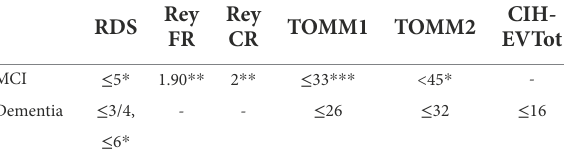
TABLE 6 Comparison of the RDS, TOMM, REY-15IMT, and CIH-EV cut-offs for MCI and dementia.